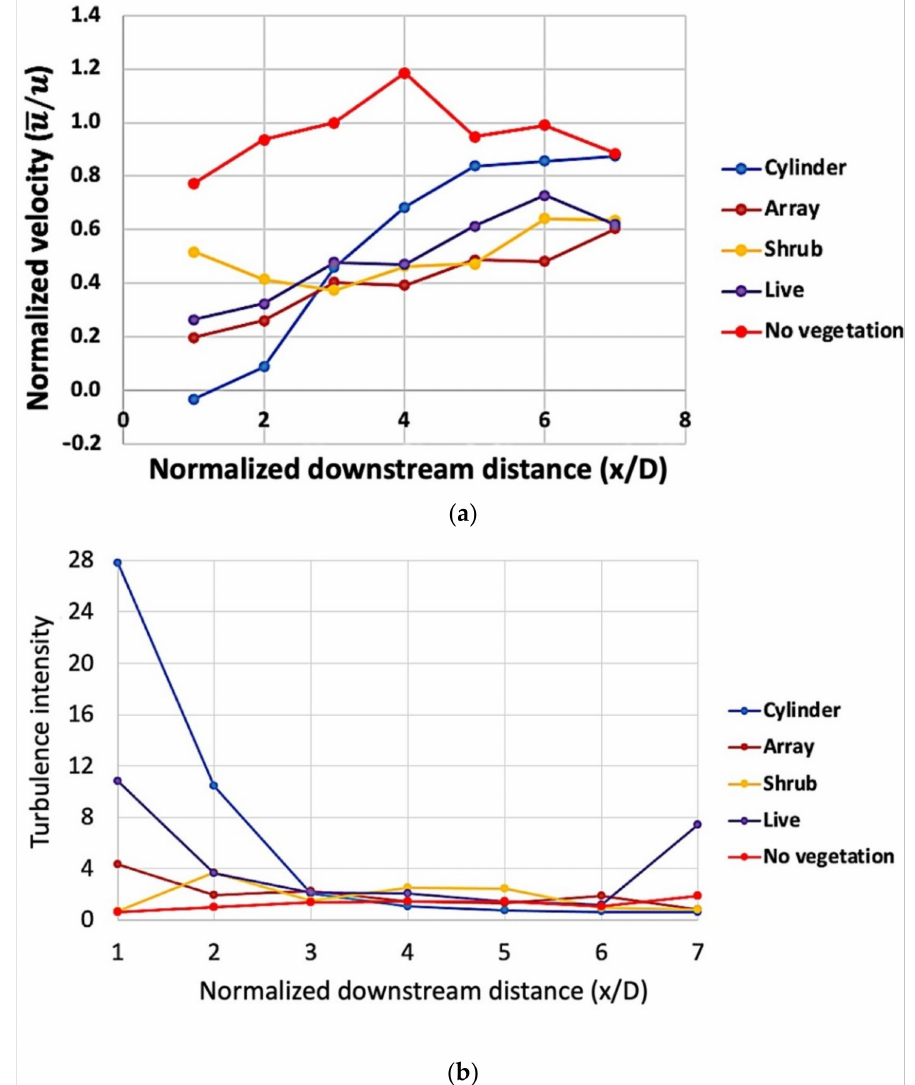
Figure 11. Variation of ( a ) depth-averaged mean flow velocity, and ( b ) turbulence intensity under different vegetation